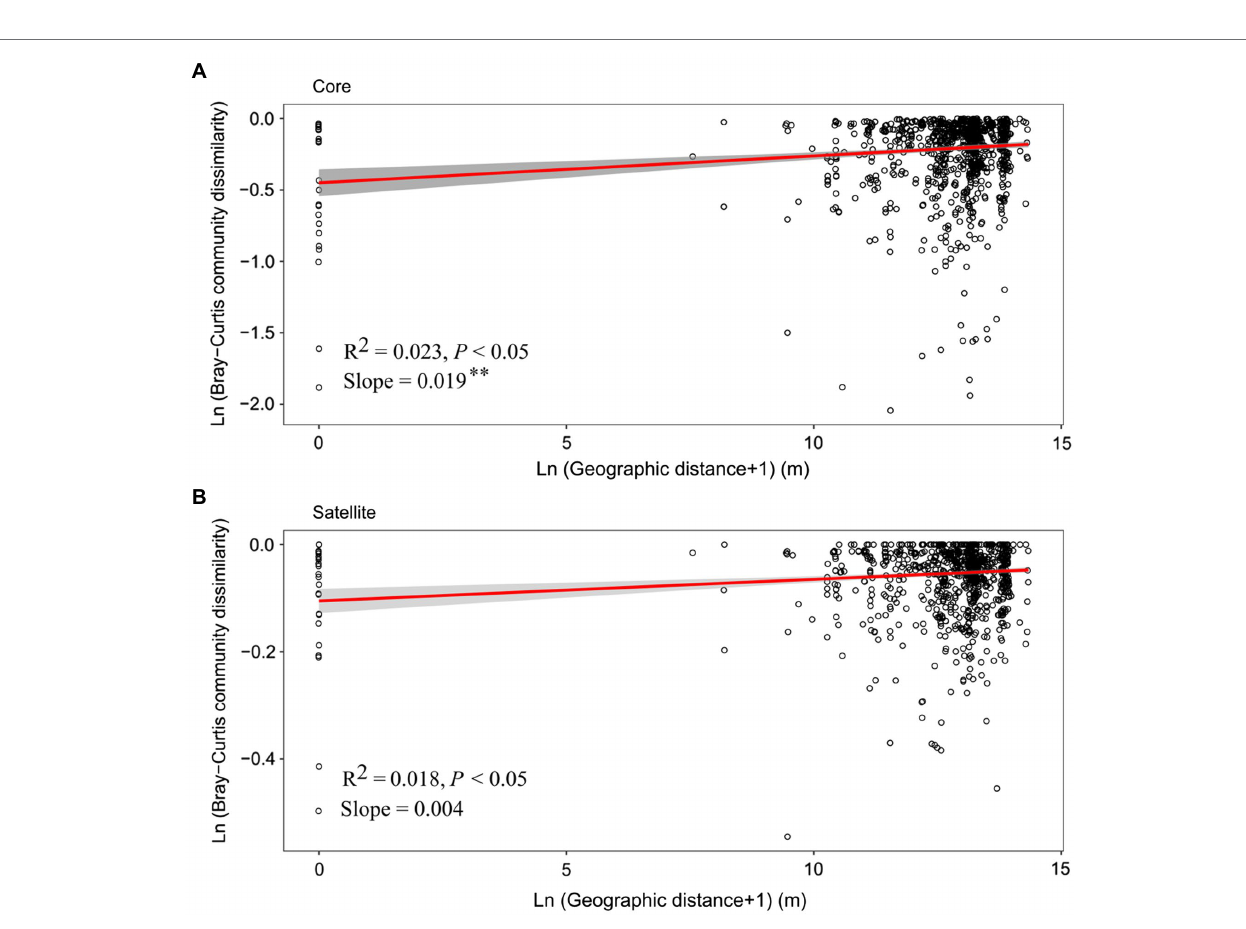
FIGURE 4 | The relationship between geographic distances and Bray-Curtis dissimilarities of the (A) core and (B) satellite bacterial sub-communities. The red line in each plot represents a linear regression model fit to Ln (geographic distance+1) vs. Ln (Bray-Curtis community dissimilarity). Gray band around the line indicates 95% confidence interval. Asterisks denote significant different between slopes ( p <